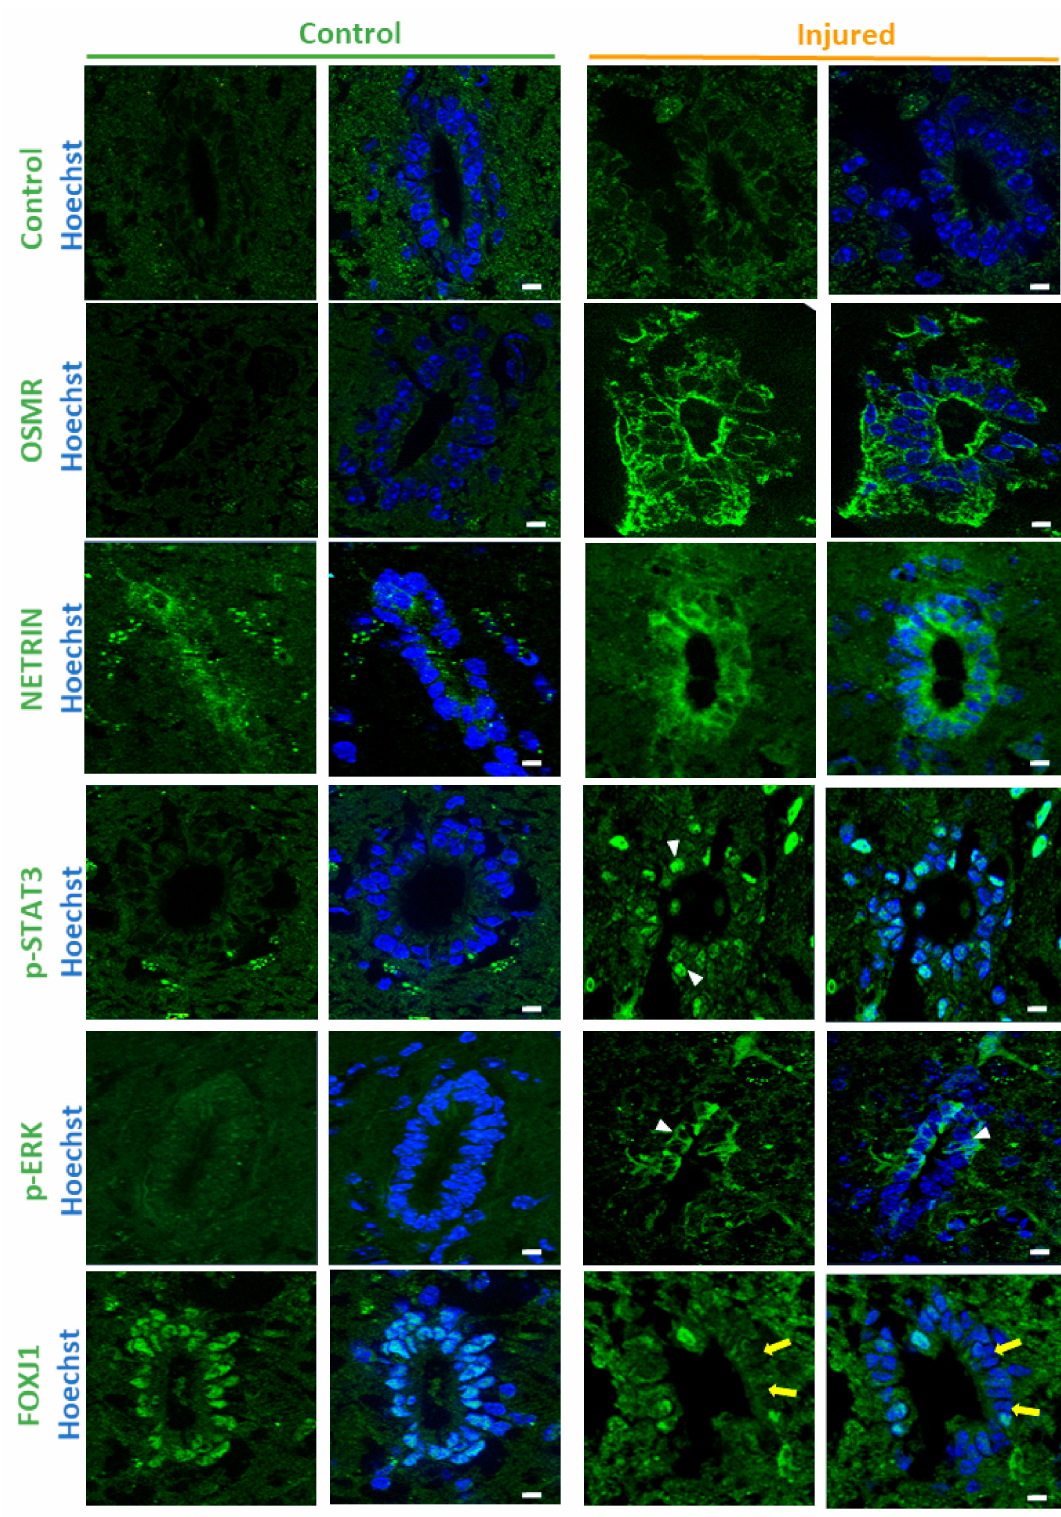
Figure 2. Immunofluorescence validation. Immunofluorescences performed on control and injured spinal cords for indicated proteins. Control immunofluorescence was performed using antibody against the synthetic DYKDDDDK TAG antigen. White arrowheads and yellow arrows show examples of positive and negative cells respectively. These images are representative of 2 independent experiments ( n = 6 animals in total, 7–15 sections examined per animal). Scale bars = 10 µ